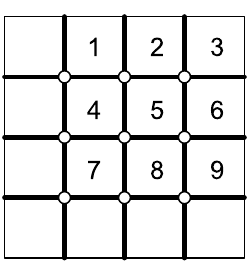
Fig. 4. Vibration isolation with piezoelectric actuators.